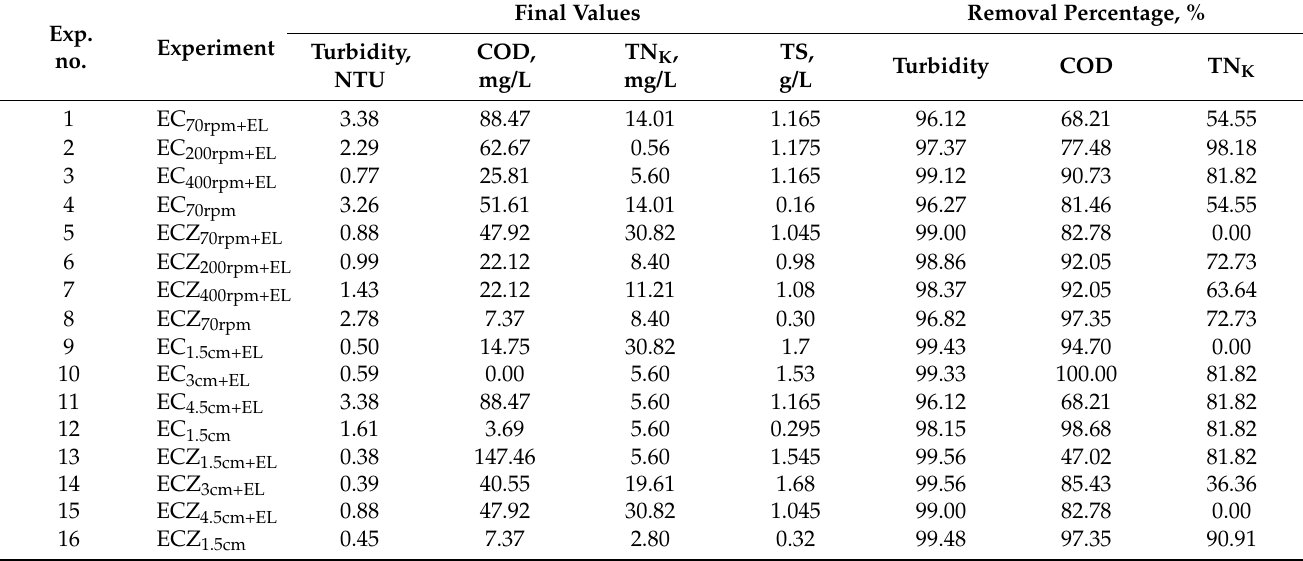
Table 4. Final values and removal efficiency of turbidity, chemical oxygen demand (COD), total Kjeldahl nitrogen (TN K ), and total solids (TS) in suspension after EC experiments.